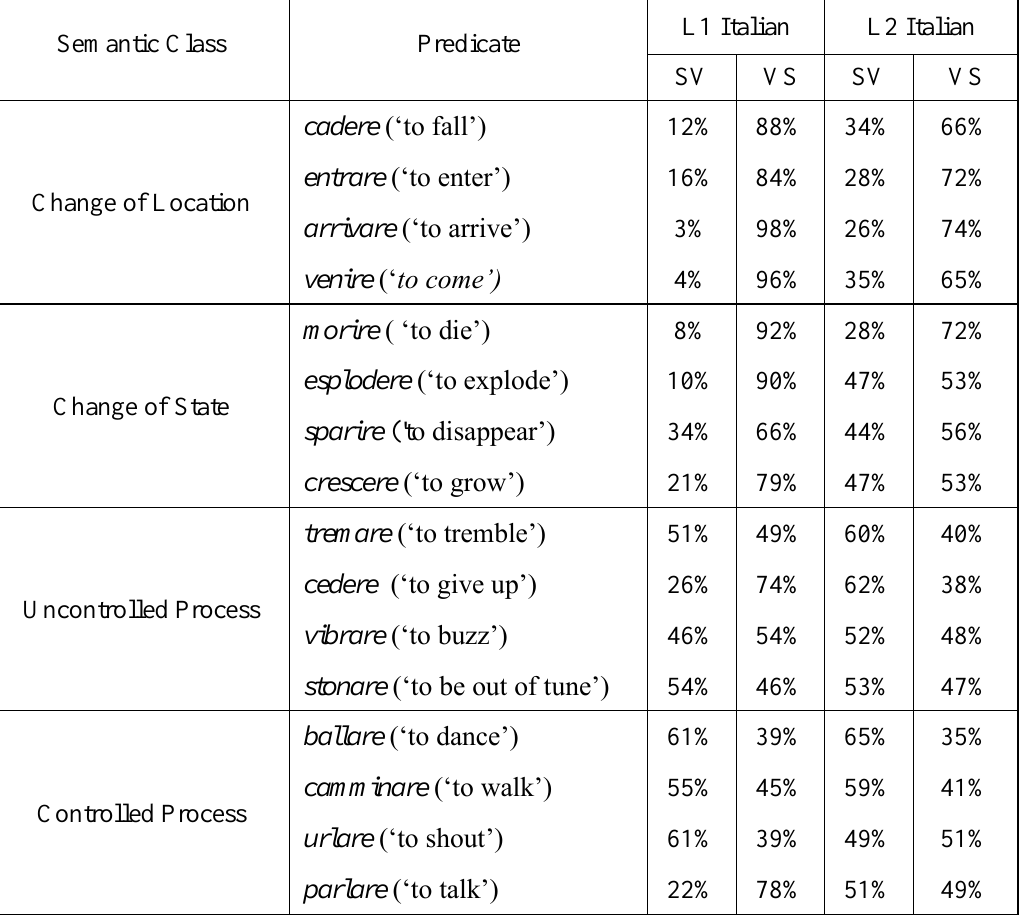
Table 7. Percentages of SV/VS orders across lexical items of the UH (L1/L2 Italian) Semantic